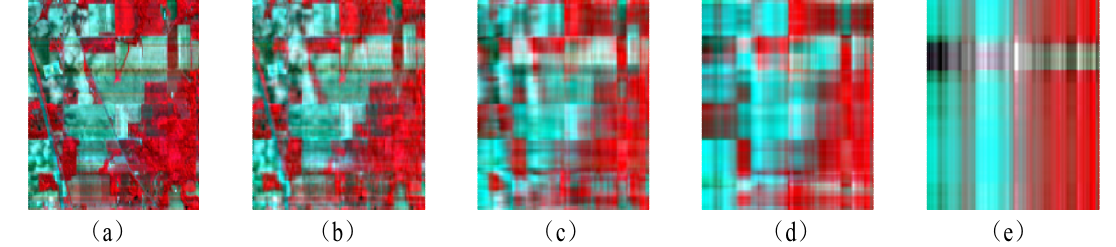
Figure 2. The low rank representation with different rank along each mode on Indian Pines dataset. ( a ) original pseudo-color map; ( b ) rank = 30 along each mode; ( c ) rank = 10 along each mode; ( d ) rank = 5 along each mode; ( e ) rank = 2 along each